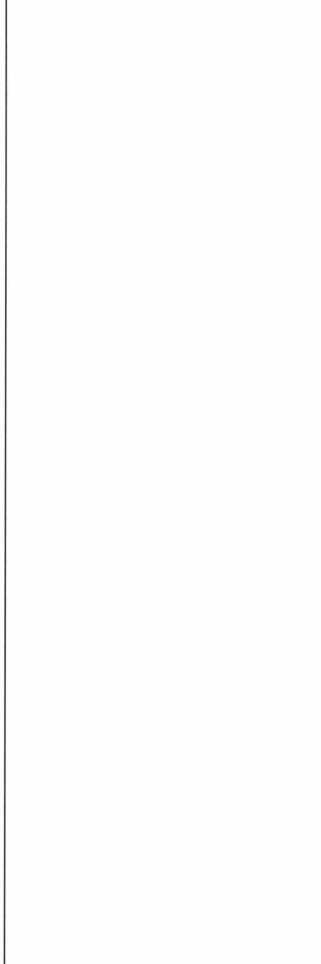
Fig. 3: Swell and dissolution behavior of agar in